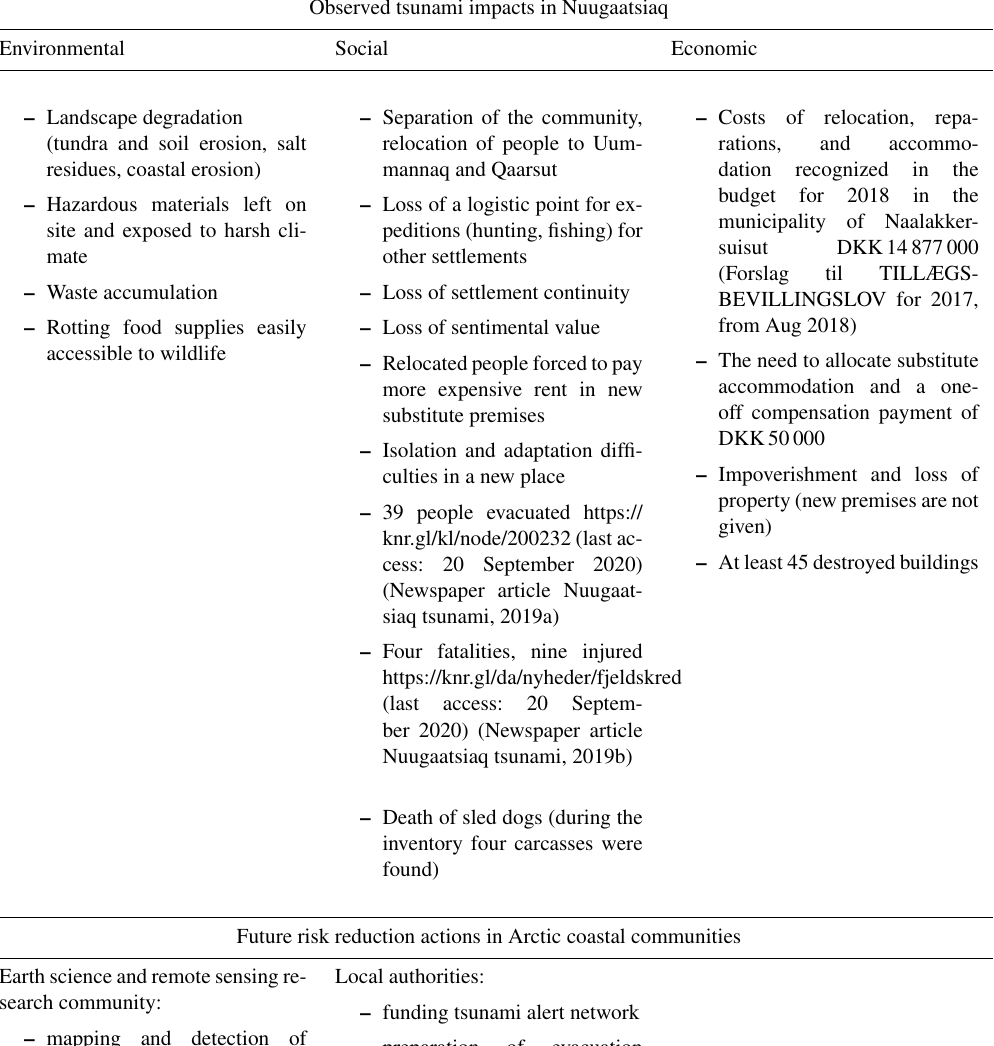
Table 1. Summary of tsunami effects on coastal landscape and the Nuugaatsiaq community and recommended hazard risk reduction